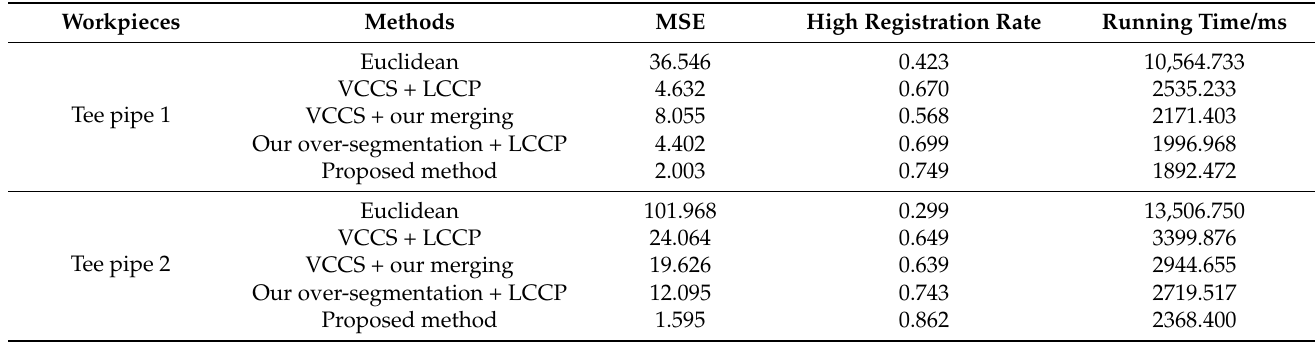
Figure 14. The registration results. ( a ) Tee pipe 1. ( b ) Tee pipe 2 ( c ) Two-way elbow. The red points in the figures are the template point clouds of different workpieces. The white points are the segmented point clouds of workpieces. Table 4. The registration results.